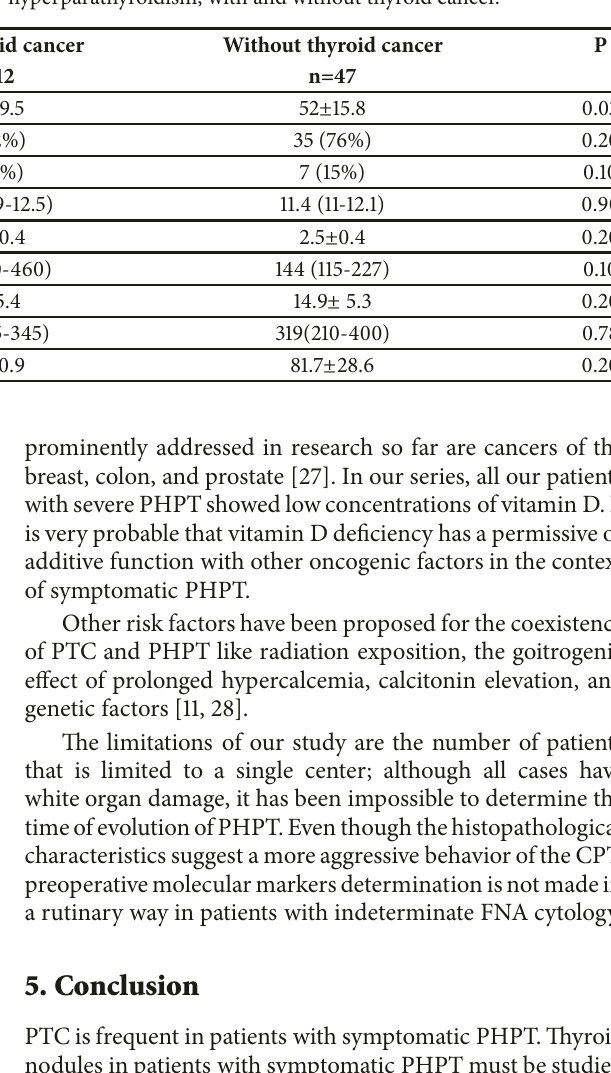
Table 2: Characteristics of patients with severe primary hyperparathyroidism, with and without thyroid cancer.